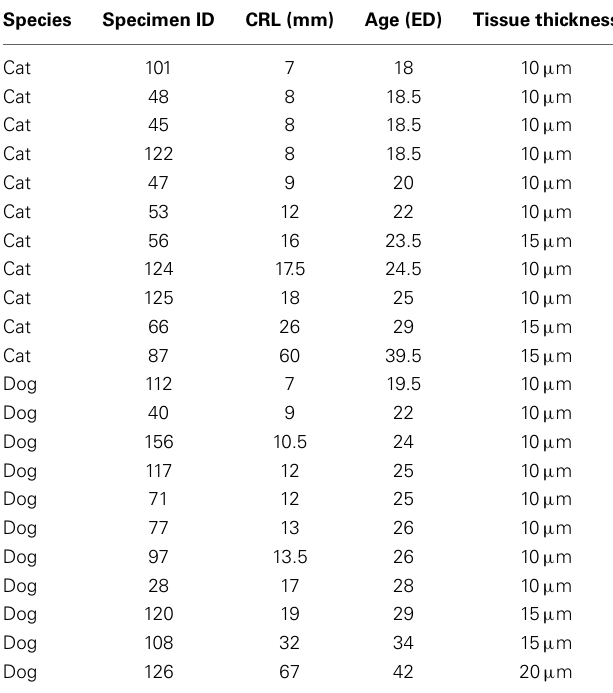
Table 2 | The ID of the specimens, crown-rump length (CRL) information and estimated ages in embryonic days (ED) are